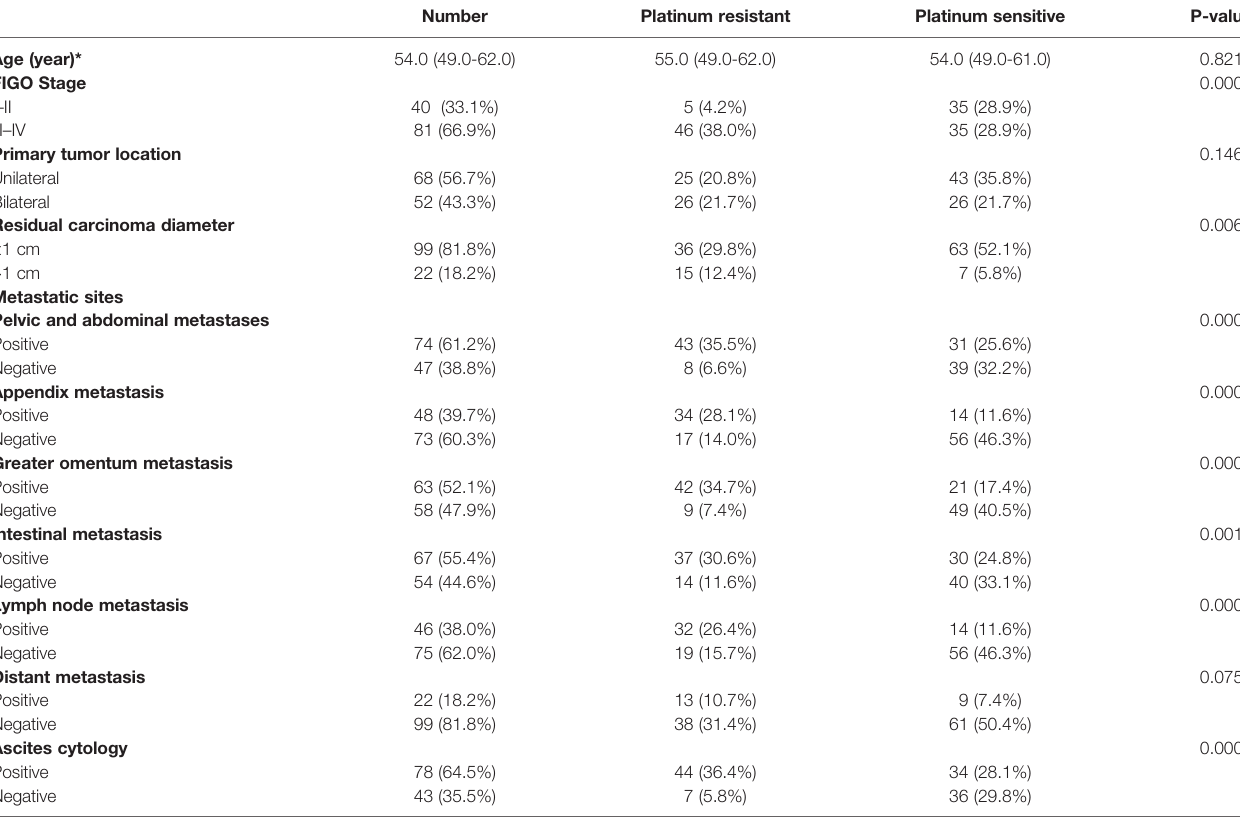
TABLE 1 | Clinical characteristics between platinum-resistant and platinum-sensitive groups.